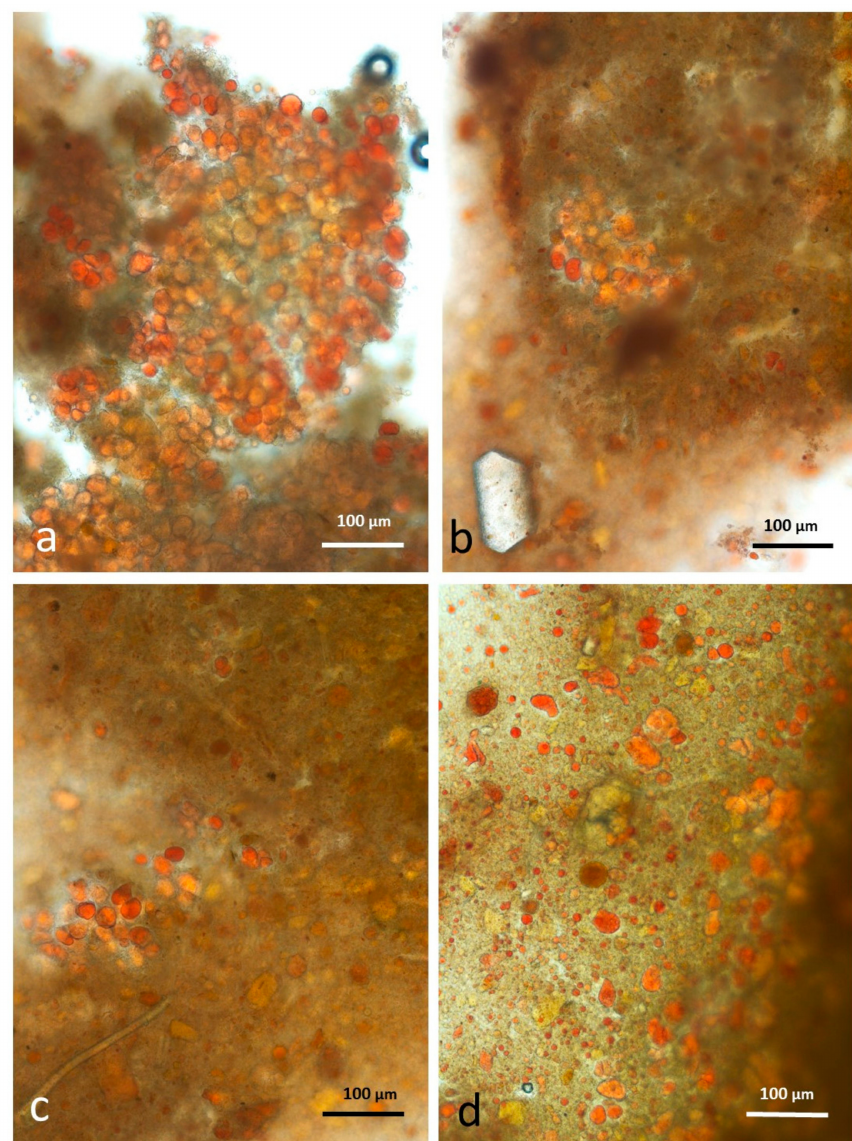
Figure 12. Faecal sample stained with Sudan IV from chopped roasted almonds diet: ( a , b ) multicellular almond particles; ( c , d ) free lipid